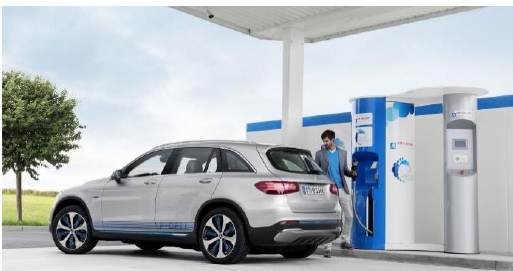
Figure 25. Mercedes GLC F-Cell SUV light vehicle: mild-hybrid type with a 50 kW FCS.